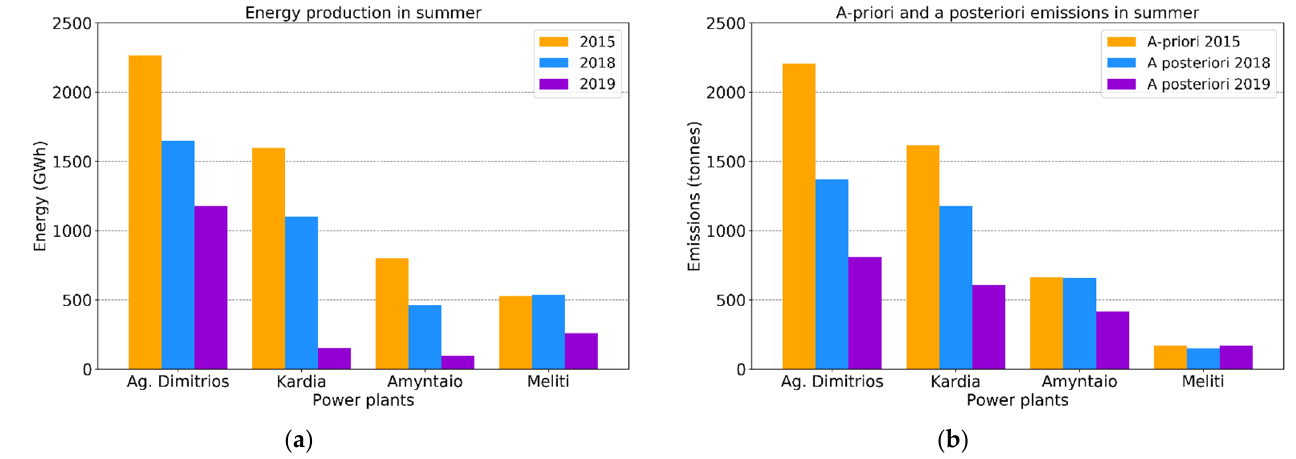
Figure 11. Bar plots ( a ) of the energy production reported for the summer of 2015 (orange bars), 2018 (blue bars) and 2019 (purple bars); ( b ) of the a priori 2015 CAMS-REG emissions in summer (orange bars) and a posteriori emissions in the summer of 2018 (blue bars) and 2019 (purple bars) for the four power plants. Table 5. Relative differences between seasonal a posteriori and a priori emissions in the four pixels and energy production of the four power plants between 2018 and 2015 and 2019 and 2015. Relative Differ- ences Relative